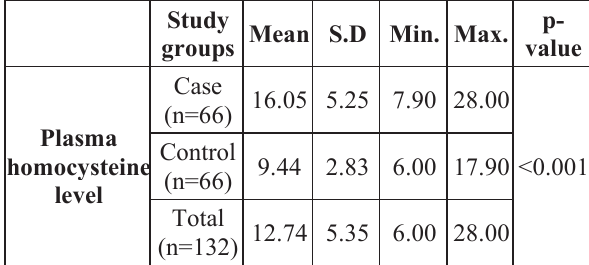
Table-2: Comparison of mean plasma homocysteine level in cases and controls (n = 132)